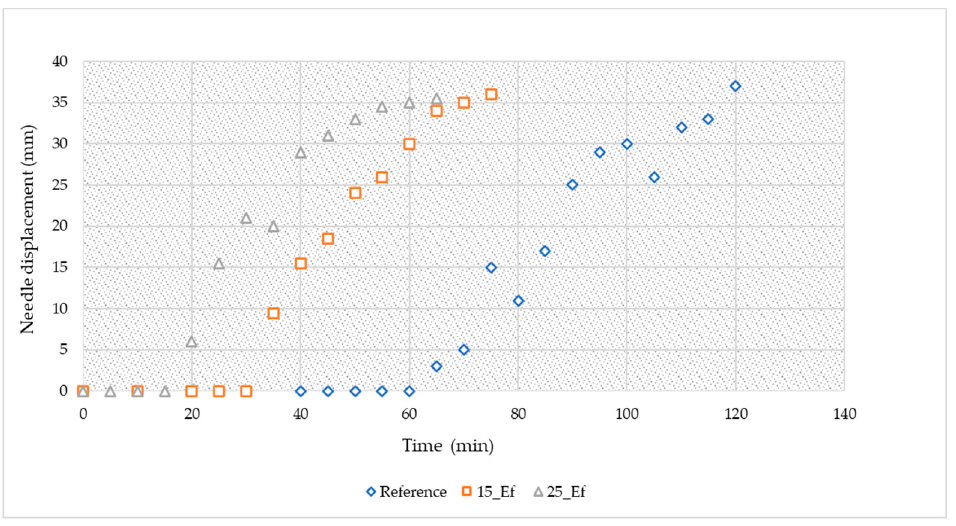
Figure 3. Needle displacement measured with the Vicat method for the studied compositions.